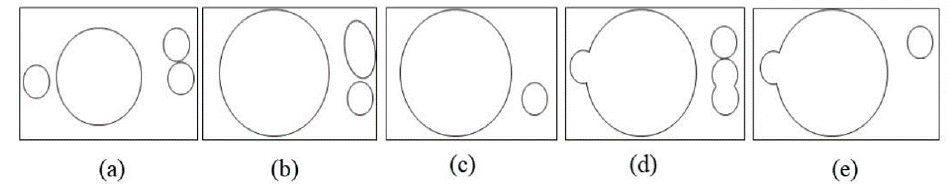
Figure 5. Integrating two layers of slices at different scales. Fine layer ( a ), coarse layer ( b ), sifted coarse layer ( c ), combined layer ( d ), and re-sifted combined layer ( e ).